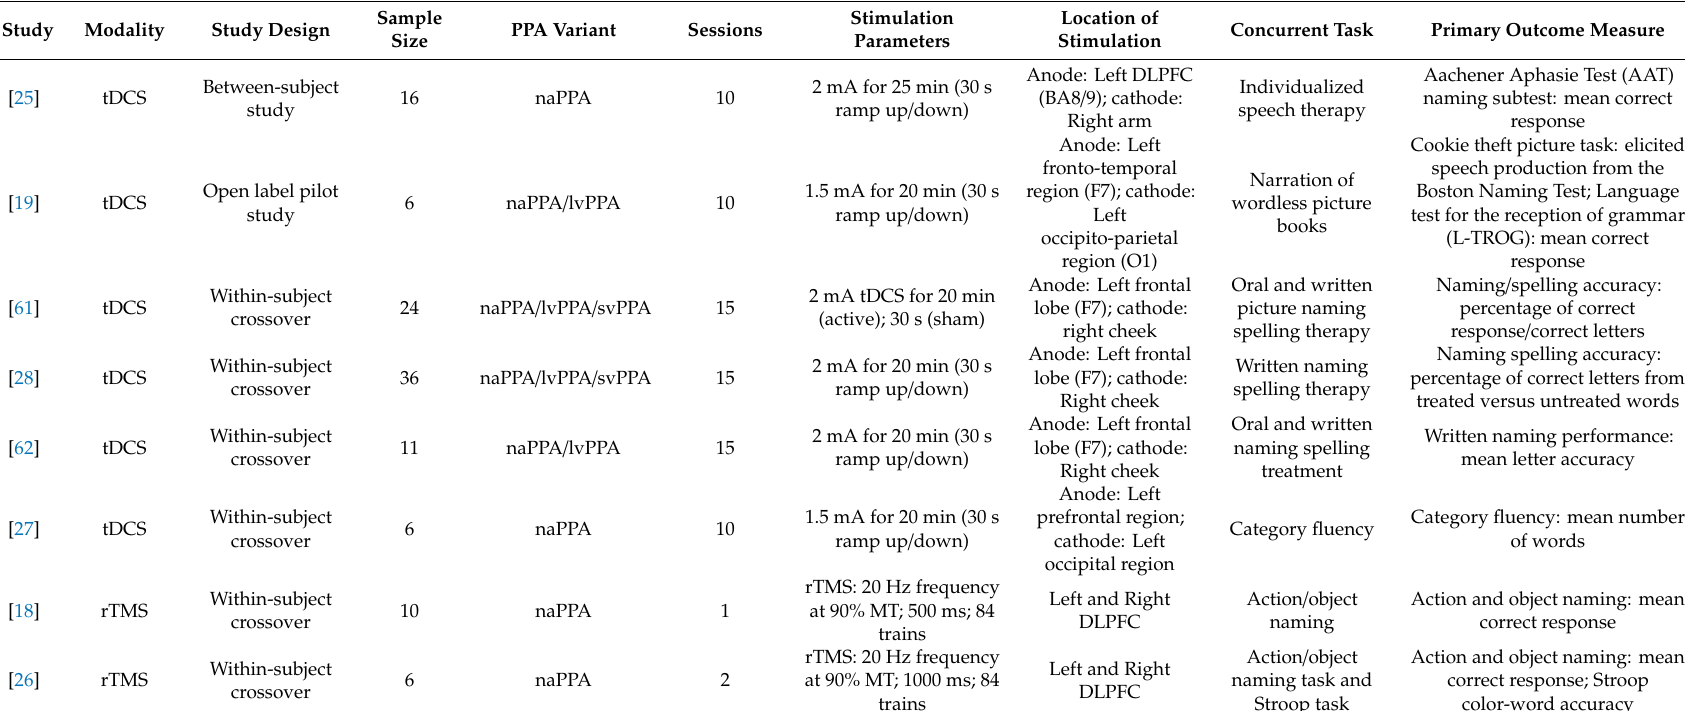
Table 1. Studies included in the